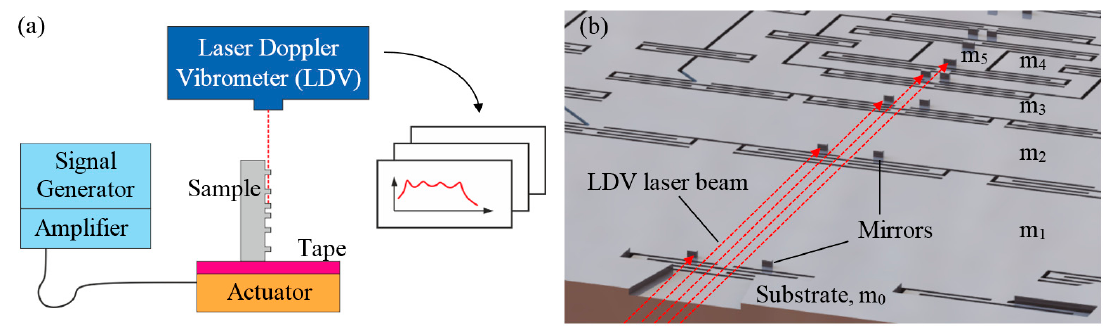
Figure 3. ( a ) Measurement setup; ( b ) Small dry-etched Si mirrors on top of all masses allow to optically track the movement (CAD drawing).